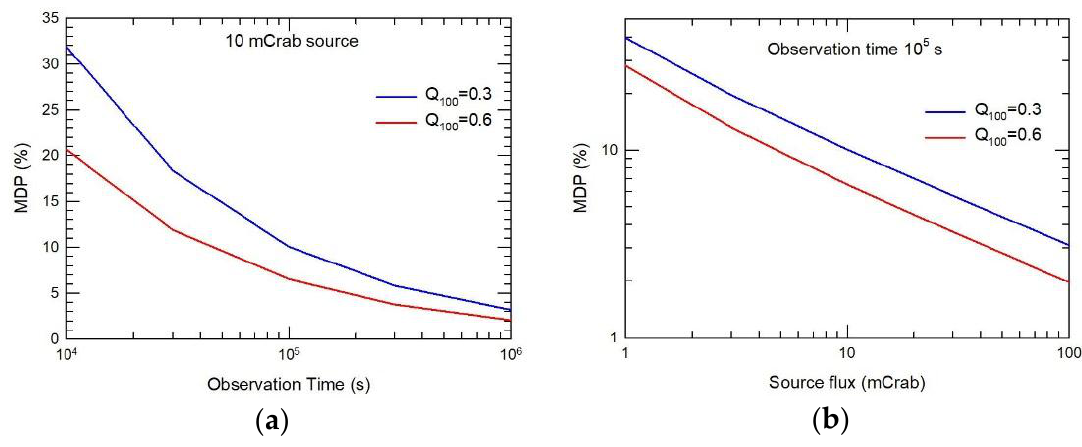
Figure 12. Polarimetric performance achievable by a 20 m focal length broadband (90–600 keV) Laue lens telescope with a fine (0.35 mm) spatial resolution focal plane in a LEO orbit: ( a ) Minimum Detectable polarization (MDP) vs observation time for a 10 mCrab source and two representative modulation factors ( Q 100 = 0.3 for all double events, Q 100 = 0.6 for double events selected using both hits energy and coordinates to maximize the modulation factor); and, ( b ) MDP vs source intensity (100% polarized) for a 10 5 s observation time.